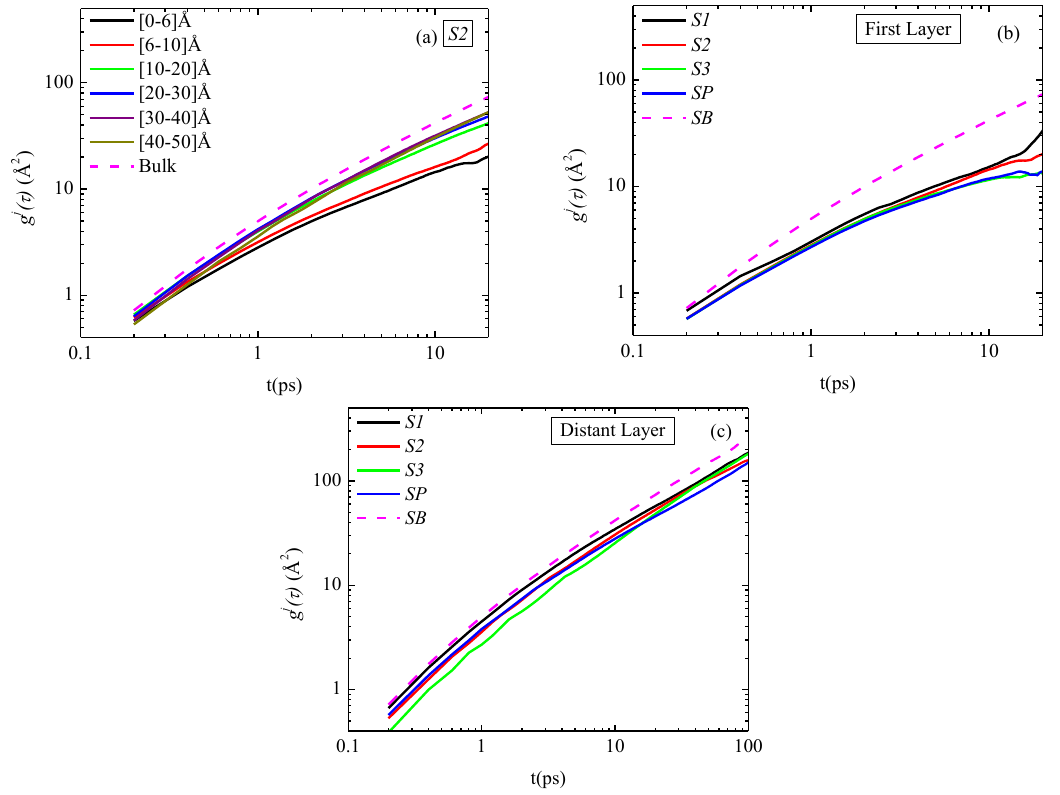
Figure 8. ( a ) Segmental mean squared displacement for polyethylene chains along R (distance from the center of the graphene layer); ( a ) Values for the S2 system, for various spherical shells; ( b ) Data for the first adsorption layer (distant layer) ( R = 0.6 nm) for all systems; ( c ) Data for the last adsorption layer ( R = L BOX /2) for all systems. In all cases the corresponding bulk curves are